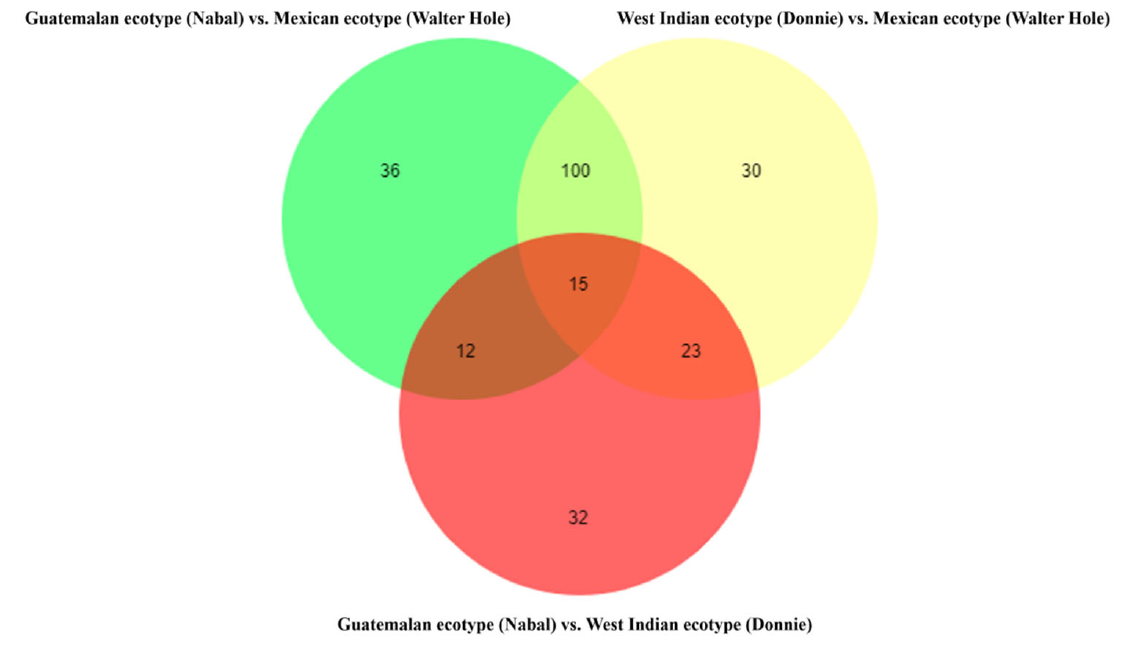
Figure 6. Detection of 248 differentially accumulated metabolites in the mature avocado mesocarps of three ecotypes. Significant differences in the relative contents of 163, 168, and 82 other metabolites were revealed in the Guatemalan ecotype (Nabal) vs. Mexican ecotype (Walter Hole), the West Indian ecotype (Donnie) vs. Mexican ecotype (Walter Hole), and the Guatemalan ecotype (Nabal) vs. West Indian ecotype (Donnie) comparisons, respectively (Table S6). In these pairwise comparisons, the main super-class with differentially accumulated metabo- lites was always lipids and lipid-like molecules (Figure 7). The metabolites with relative contents that differed by a factor of 10,000 between ecotypes were identified as adrenic acid (lipid or lipid-like molecule), ethyl isopropyl ketone (organic oxygen compound), and 2 (cid:48) -O-methylcajanone (phenylpropanoid or polyketide) (Guatemalan ecotype (Nabal) vs. Mexican ecotype (Walter Hole)), as well as geranyl-PP and jasmonic acid (lipid or lipid-like molecules) and ethyl isopropyl ketone (organic oxygen compound) (West Indian ecotype (Donnie) vs. Mexican ecotype (Walter Hole)). The fold-changes in the relative contents of differentially accumulated metabolites were substantially lower for the Guatemalan ecotype (Nabal) vs. West Indian ecotype (Donnie) comparison than for the other pairwise comparisons, with the maximal fold-change (92) detected for scopoletin (phenylpropanoid or polyketide) (Table